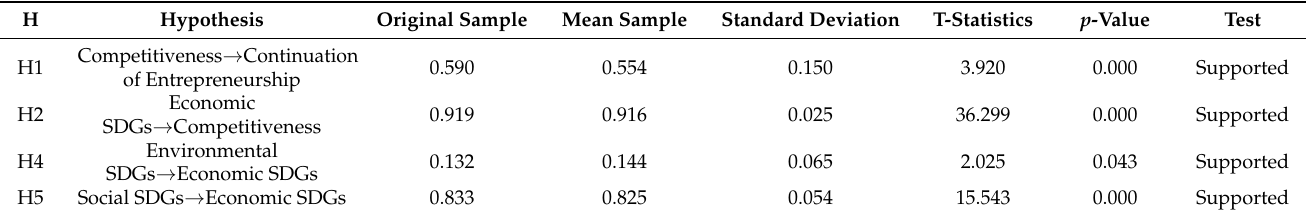
Table 4. Hypothesis